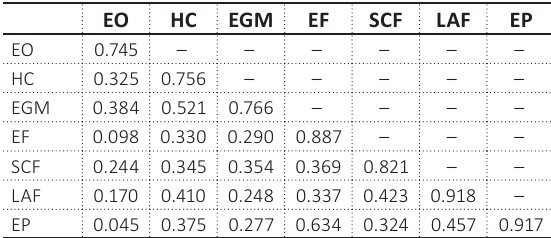
Table 5. Path coefficients for the